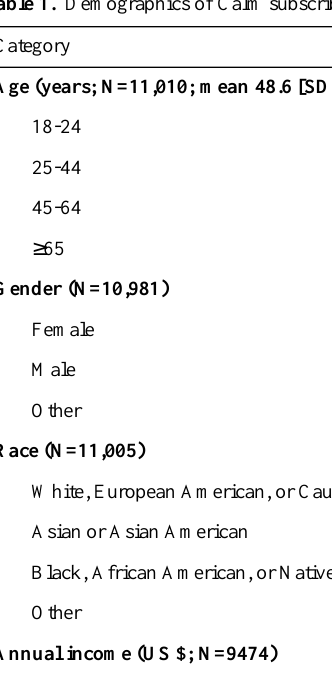
Table 1. Demographics of Calm subscribers (N=12,151).